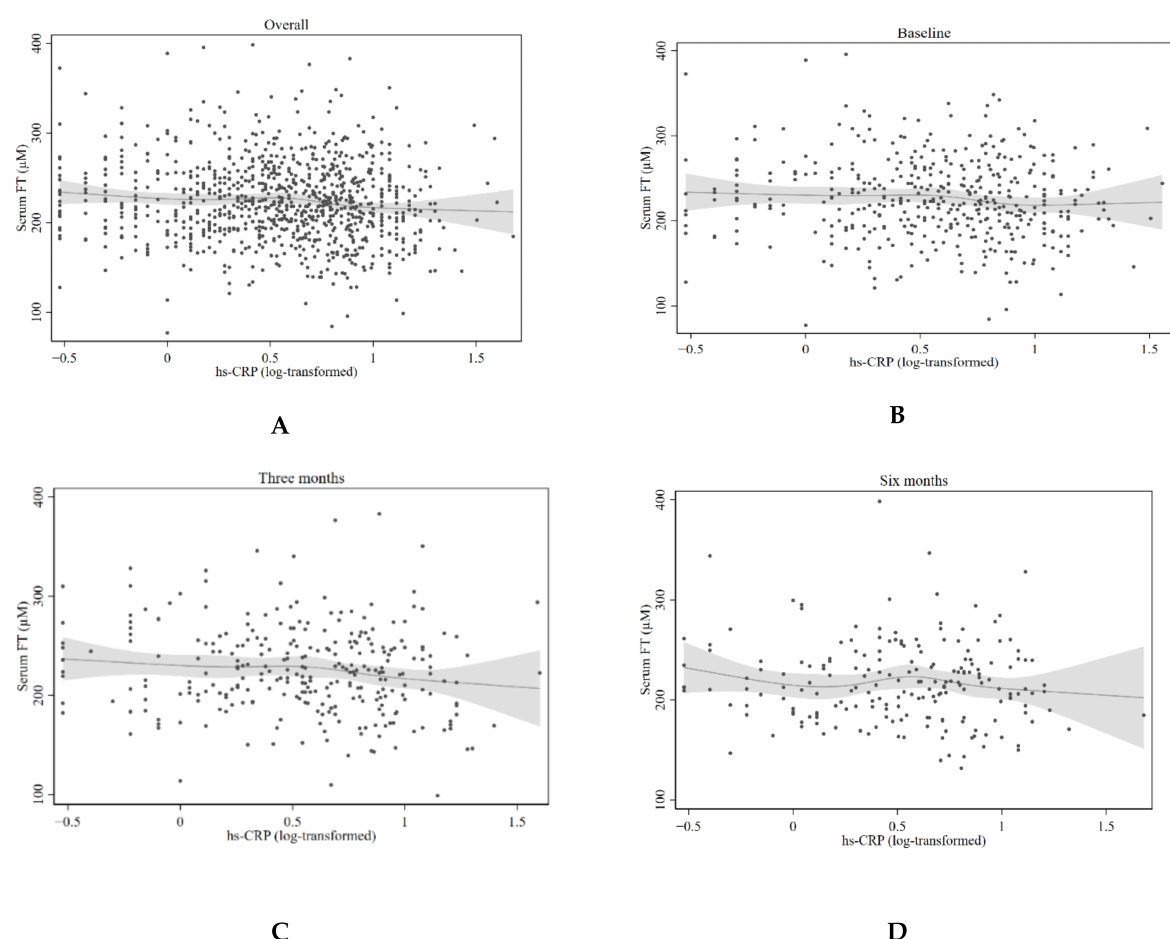
Figure 4. Estimated associations of serum FT with hs-CRP based on restricted cubic splines. The figure shows restricted cubic splines with scatter plot of serum FT and hs-CRP (log-transformed). A dot represents one case. The regression line for each spline segment for serum FT levels is connected with smoothed transitions. The gray area represents the 95% CI. The restricted cubic spline regression does not reveal significant deviations from linear associations. ( A ) Estimated